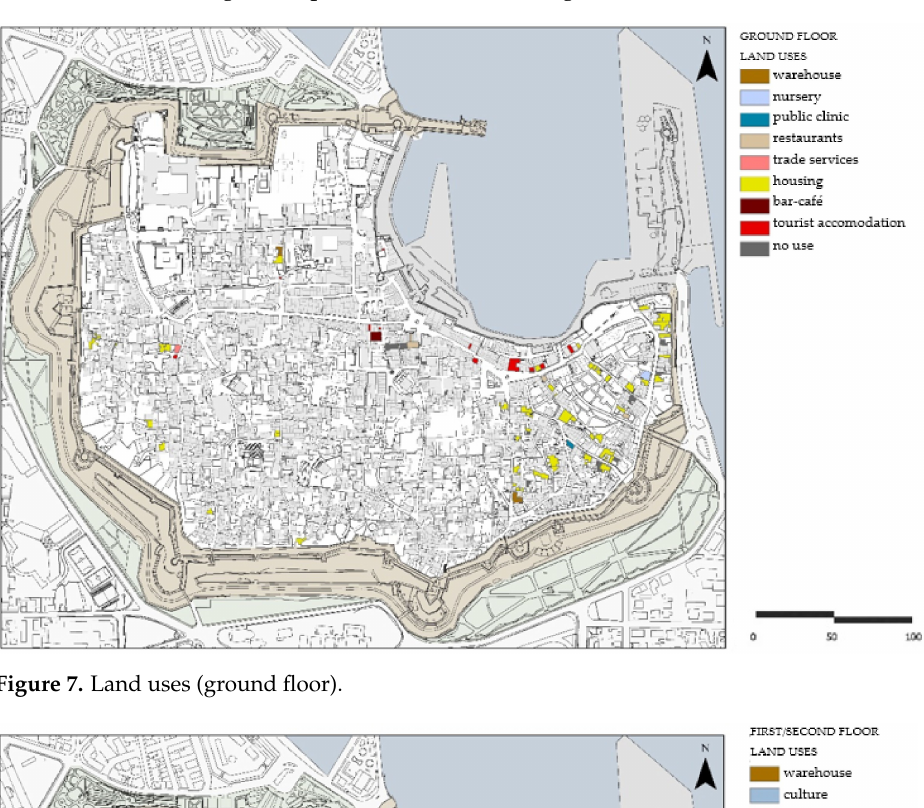
Figure 7. Land uses (ground floor).